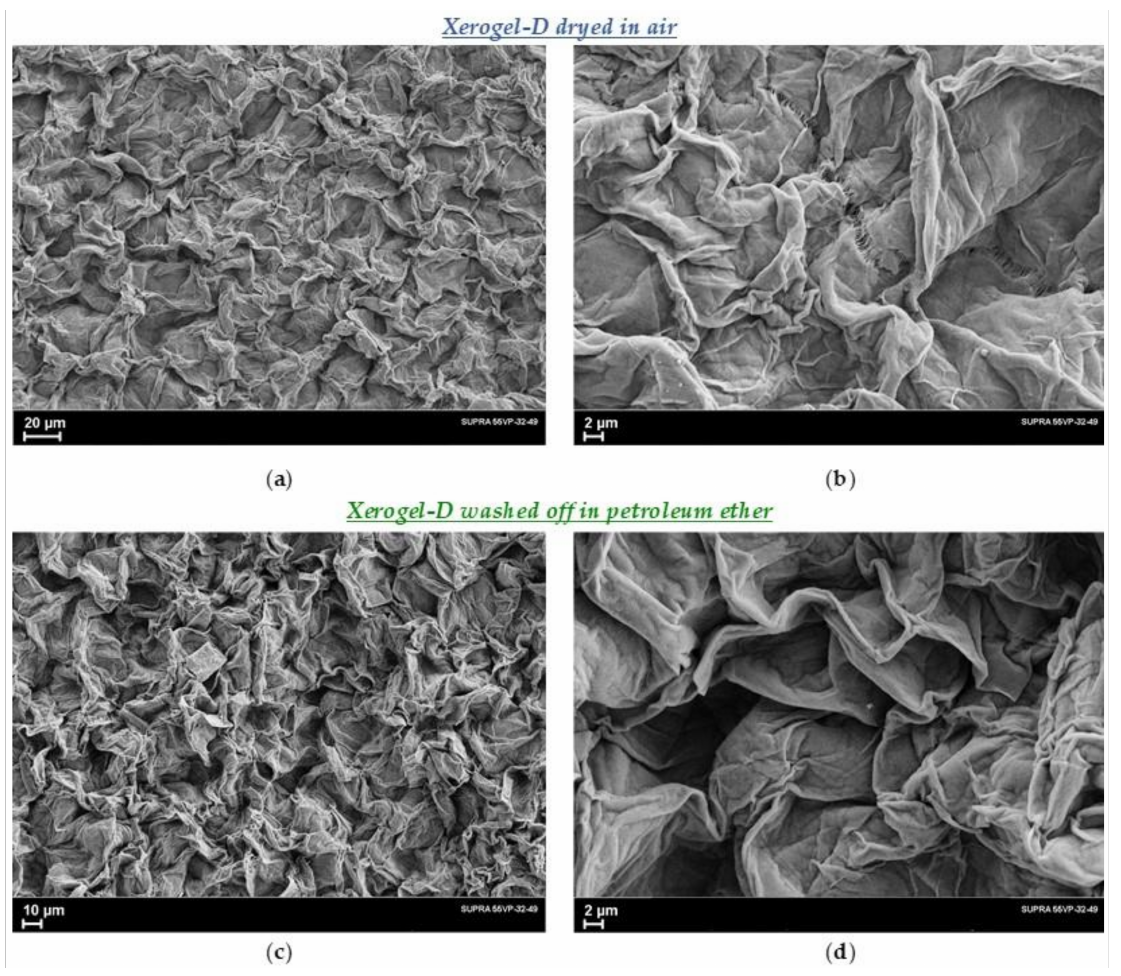
Figure 4. SEM micrograph of the xerogel-D films obtained from a 1.5% solution in decalin: ( a , b )